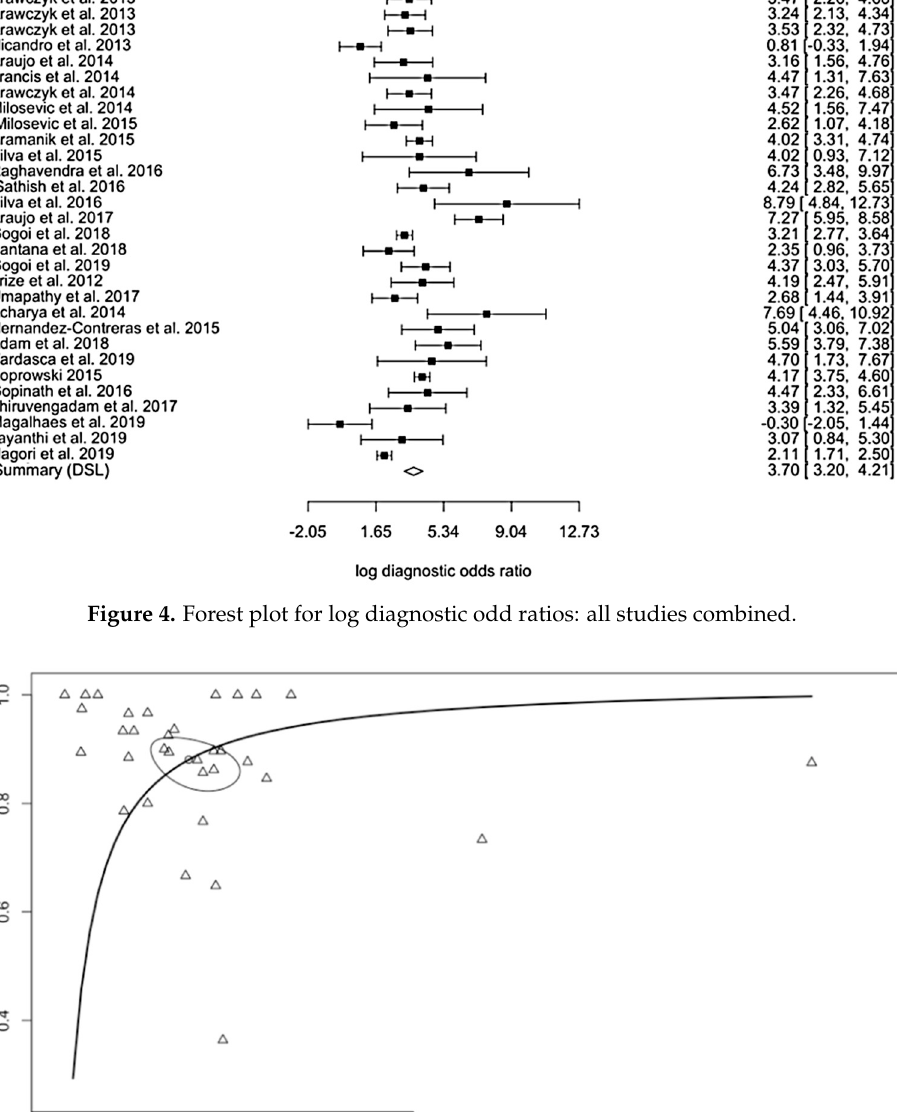
Figure 3. Forest plot for specificity: all studies combined.